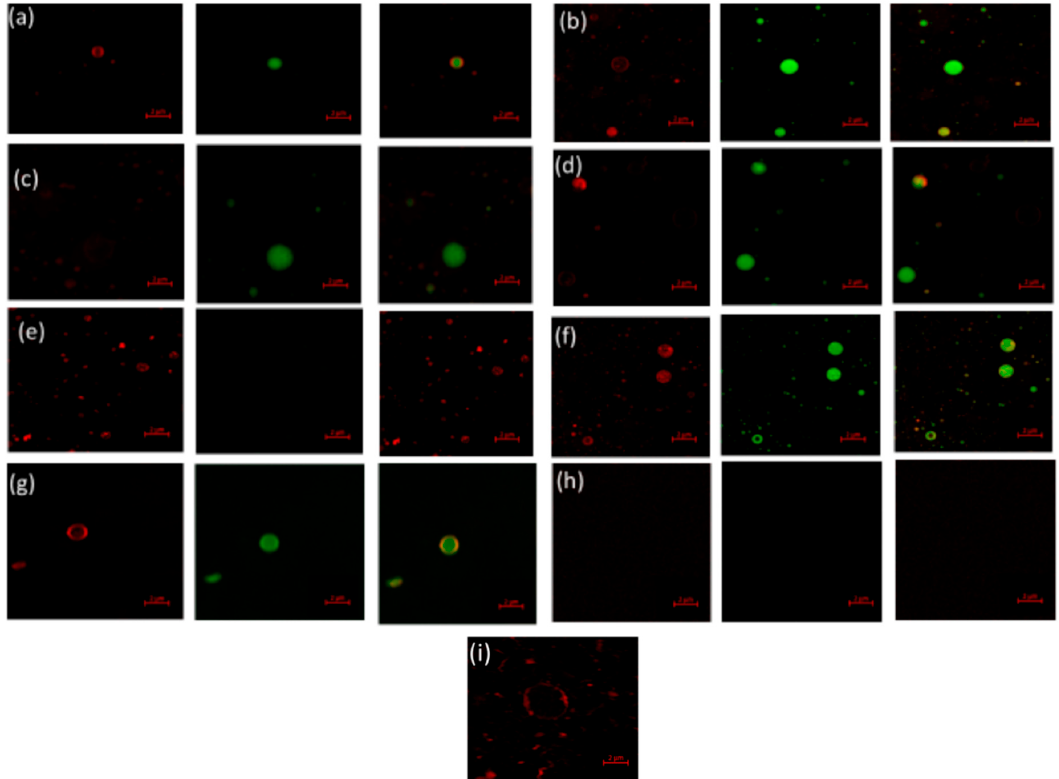
Figure 4. Confocal microscopy images of calcein-loaded GUV, after interaction with ( a ) CUR/SPPI, ( b ) CUR/PPI, ( c ) CUR/SPPI/CHI, ( d ) CUR/PPI/CHI, ( e ) SPPI/CHI, ( f ) PPI/CHI nanoparticles, and ( g ) calcein-loaded GUV, in the absence of nanoparticles, ( h ) calcein-loaded GUV after treatment with Triton X-100 (10%) positive control, and ( i ) GUV without calcein. Images in the first column were acquired at rhodamine B channel (GUV labeled with rhodamine), the second column is at calcein channel, and the third column is the merger of both. Scale bar is 2 µ